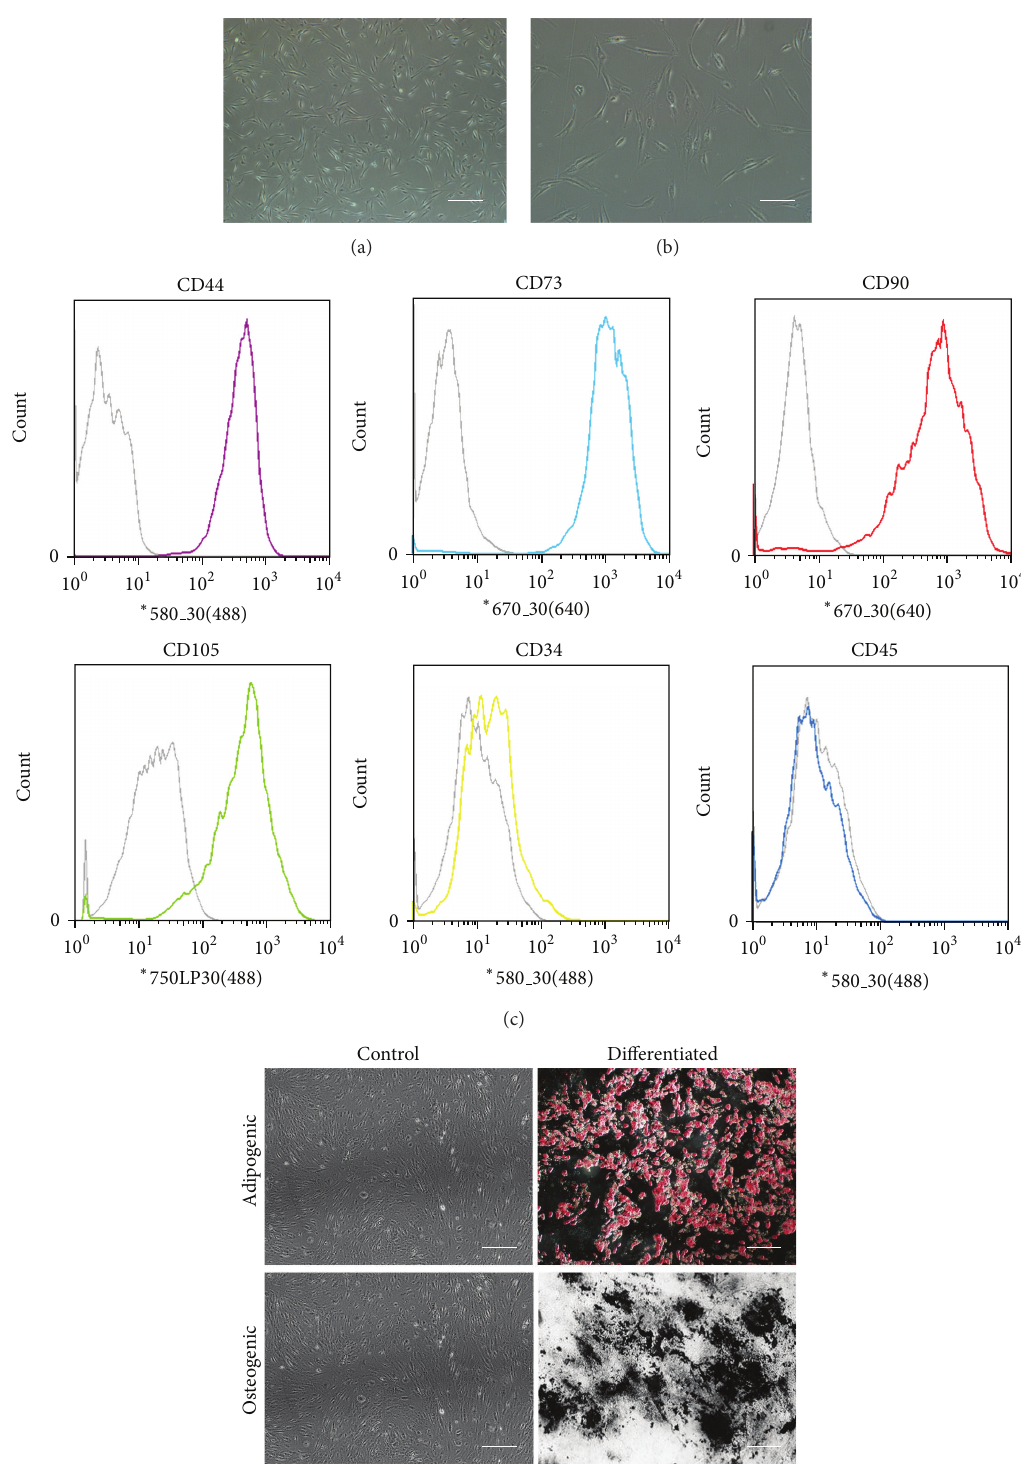
Figure 1: Characterization of ADSCs. ADSCs exhibited a flattened fibroblast-like morphology. Observed under a microscope of 40x (a) and 100x (b). Immunophenotype of ADSCs (c). ADSCs were stained with antibodies against the indicated antigens and analyzed by flow cytometry. Representative histograms are shown as colored lines, and the respective isotype controls are shown as a gray line. ADSCs were positive for CD44, CD73, CD90, and CD105 and negative for CD34 and CD45. ADSCs are able to differentiate into adipogenic and osteogenic lineages, as shown by staining with Oil Red O and Von Kossa, respectively (d). Undifferentiated (control) ADSCs are not marked with the stains. Scale bars, 100 𝜇 m ((a), (d)) and 50 𝜇 m